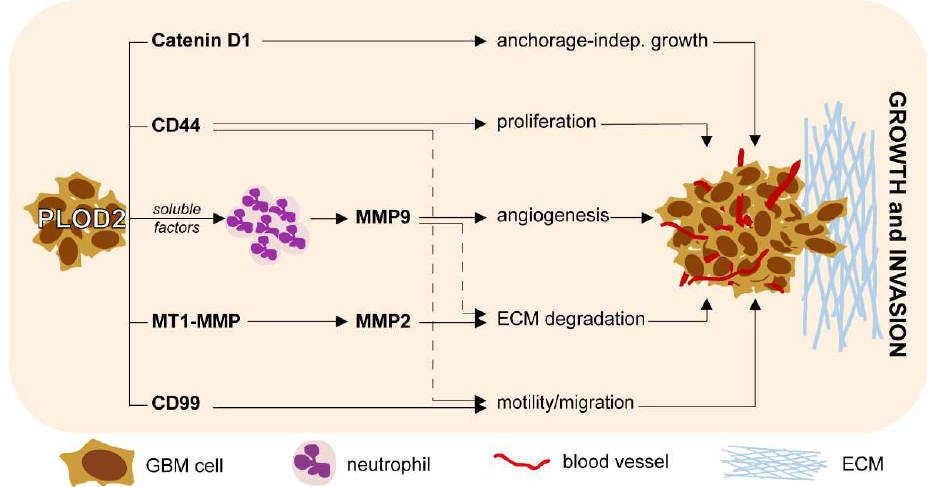
Figure 7. Schematic representation of the main findings integrated in the biology of GBM